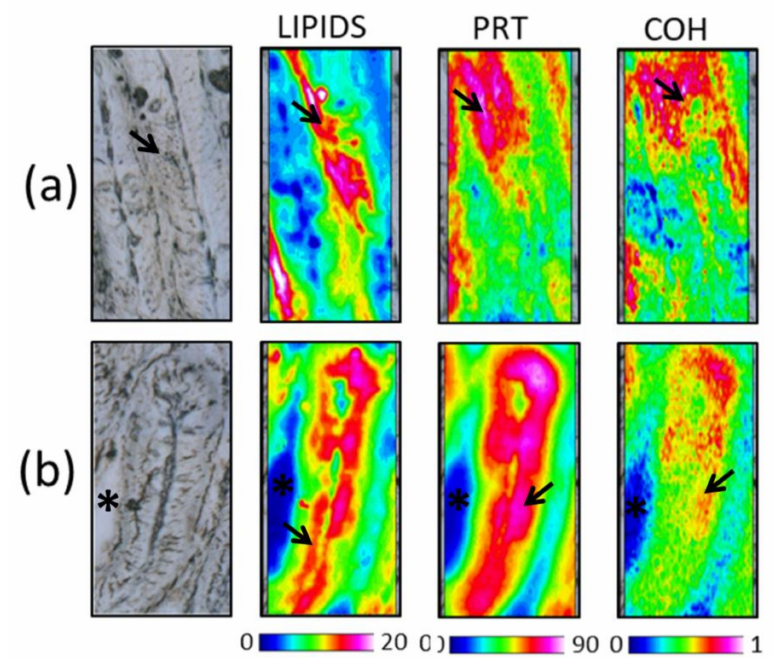
Figure 5. Hyperspectral Imaging analysis of representative sections of medium ( a ) and distal ( b ) intestine of CF dietary groups. False color images (164 × 328 µ m) showing the topographical distribution of: lipids (Lip, 0–20 color scale), proteins (PRT, 0–90 color scale), and glycosylated compounds (COH, 0–1 color scale). Black/dark blue colors represent the lowest absorbance values of the infrared radiation, while white/light pink represent the highest ones. Arrows indicate the mucosa epithelial layer; asterisks indicate the intestinal